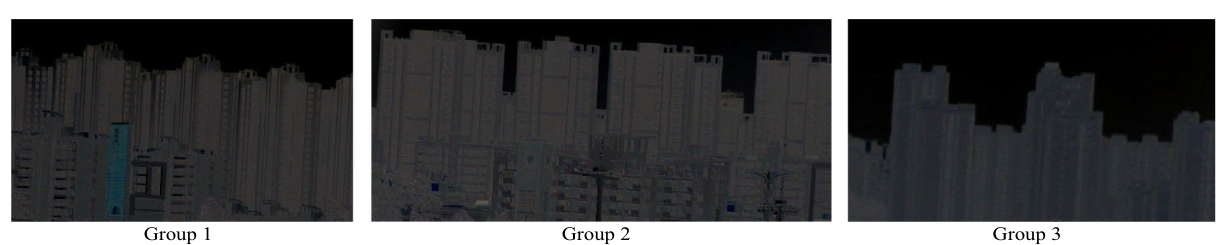
Figure 6. Images of polarization degree in group